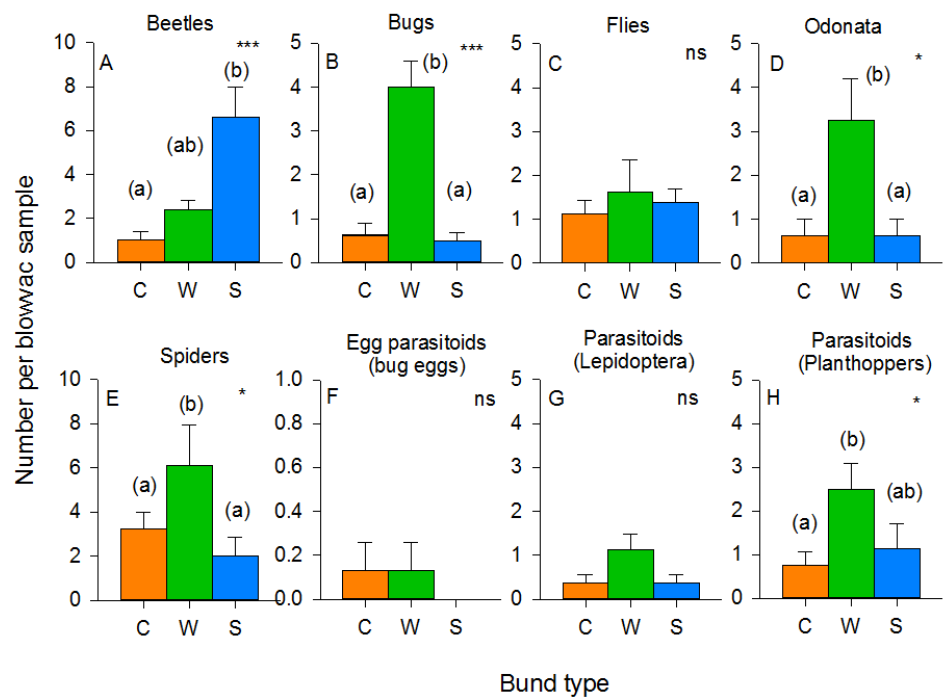
Figure 5. Relative abundance of the natural enemies of rice herbivores on clear bunds (C, brown bars), weedy bunds (W, green), and sesame bunds (S, blue) during sampling conducted on 1 September 2011. Graphs indicate the numbers of predatory beetles ( A ), bugs ( B ), flies ( C ), dragonflies and damselflies ( D ), and spiders ( E ) captured during Blow-vac sampling. The numbers of parasitoids of rice bugs ( F ), lepidopteran pests ( G ), and planthoppers/leafhoppers ( H ) are also indicated. GLM results for the effects of bund vegetation are indicated for each predator group; ns = p > 0.05, * = p < 0.05, *** = p < 0.001. Lowercase letters indicate homogenous bund groups.